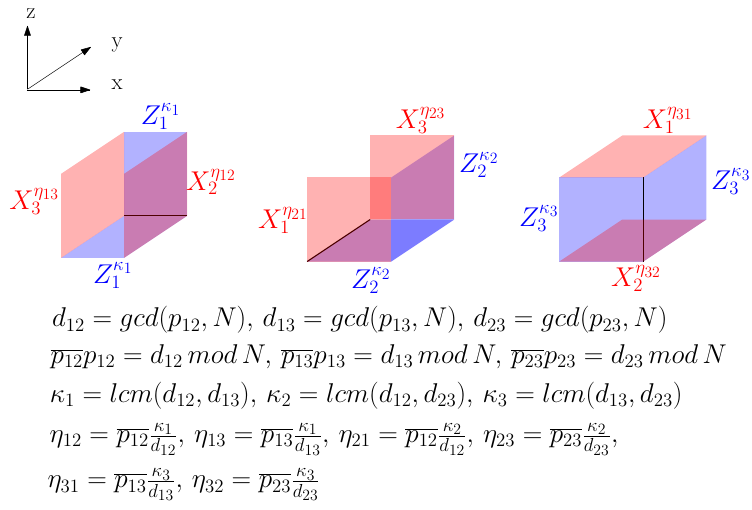
Figure 5: Operators creating lineons that commute with the edge terms. They sat- isfy non-trivial commutation relations. κ